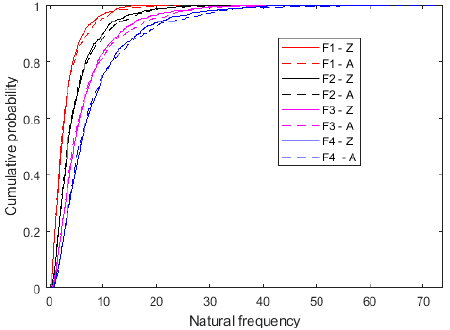
Figure 4. Cumulative probability of natural frequencies (the unit for the natural frequency is THz).